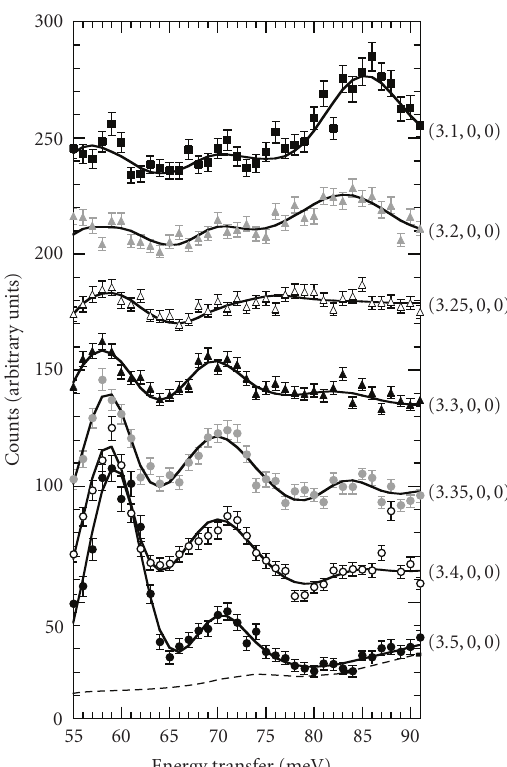
Figure 8: Bond-bending (around 60 meV) and bond-stretching (above 65 meV) branches in optimally-doped LSCO [31].